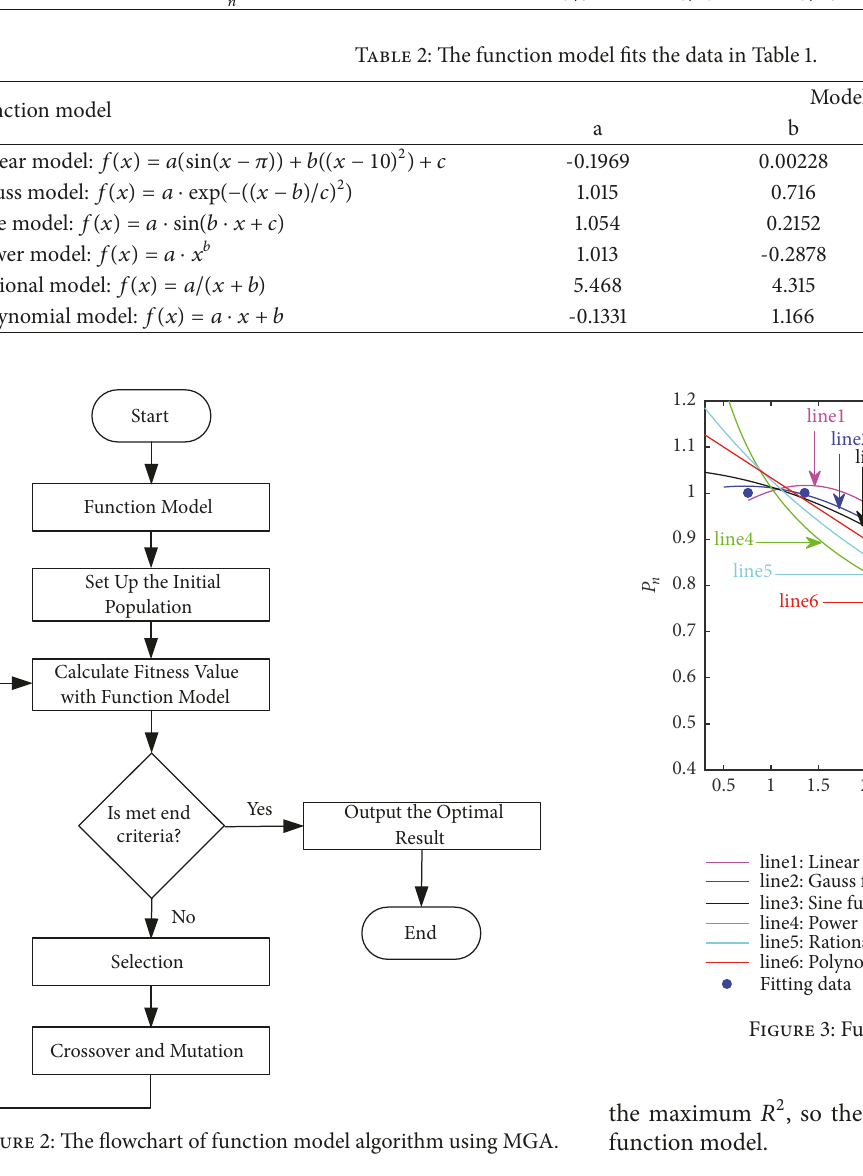
Different function model is used to fit the data of Table 1, and the result is shown in Table 2.